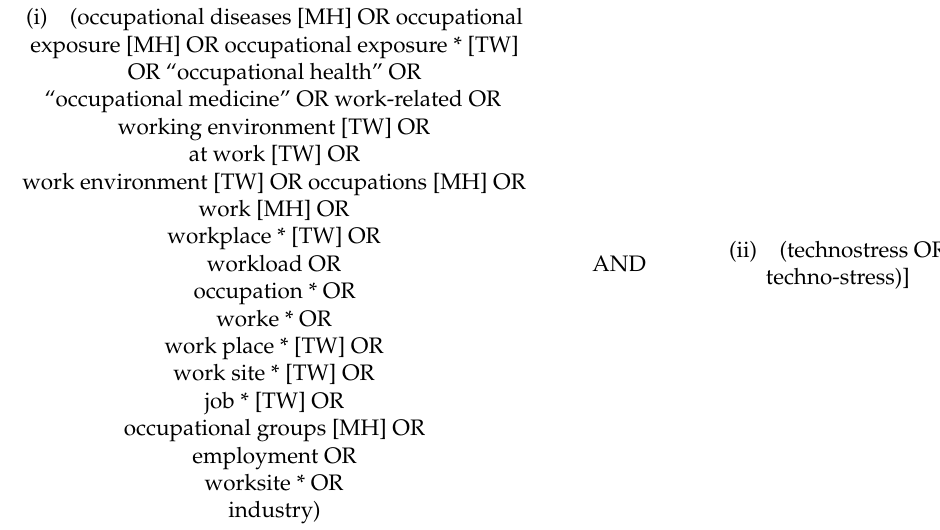
Table A2. Search strategy (PubMed and PubMed Central, slightly adapted for other